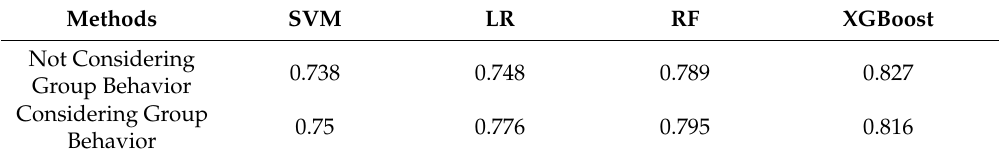
Table 8. F1 scores of considering and not considering group behavior.